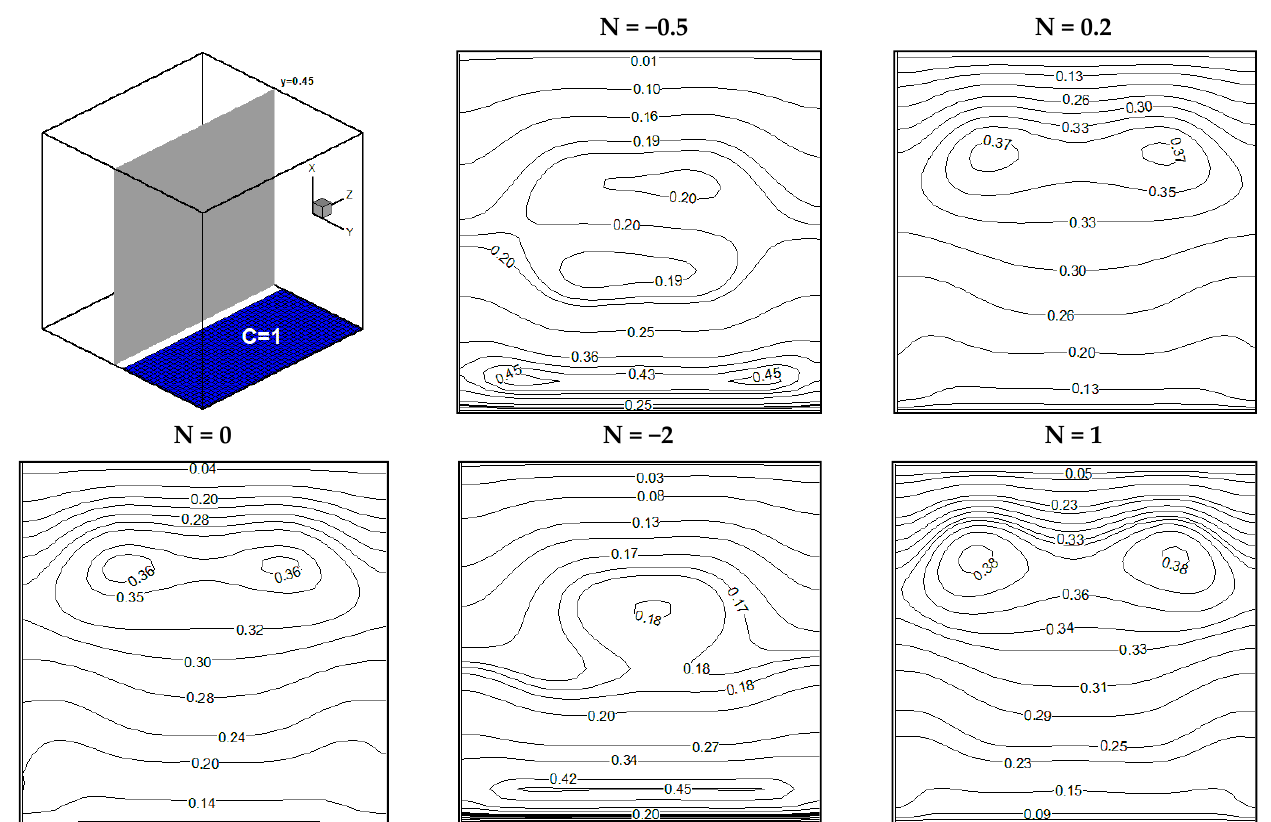
Figure 14. Iso-contours of the contaminant concentration in the building without a barrier, with the y = 0.45 plane for Ra = 2 × 10 4 and a different buoyancy ratio.